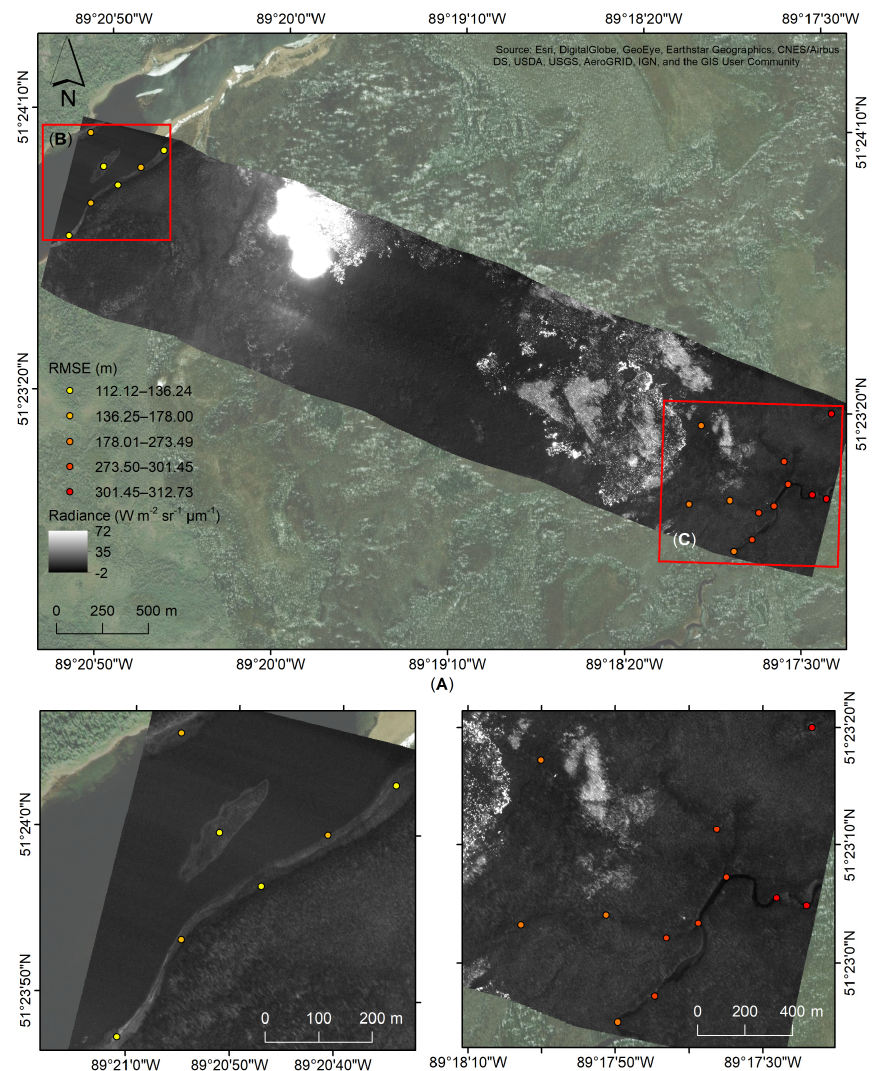
Figure 10. ( A ) An example of reported RMSE of the orthoimage (before the georeferencing process) in units of radiance (Wm − 2 sr − 1 µm − 1 ) of FL-04, at an integration time of 1.4 ms, from F-04 acquired on 3 August 2017. Areas showing the misa- lignments and RMSE found following the geocorrection process for ( B ) the northwest and ( C ) southeast corners of the flight